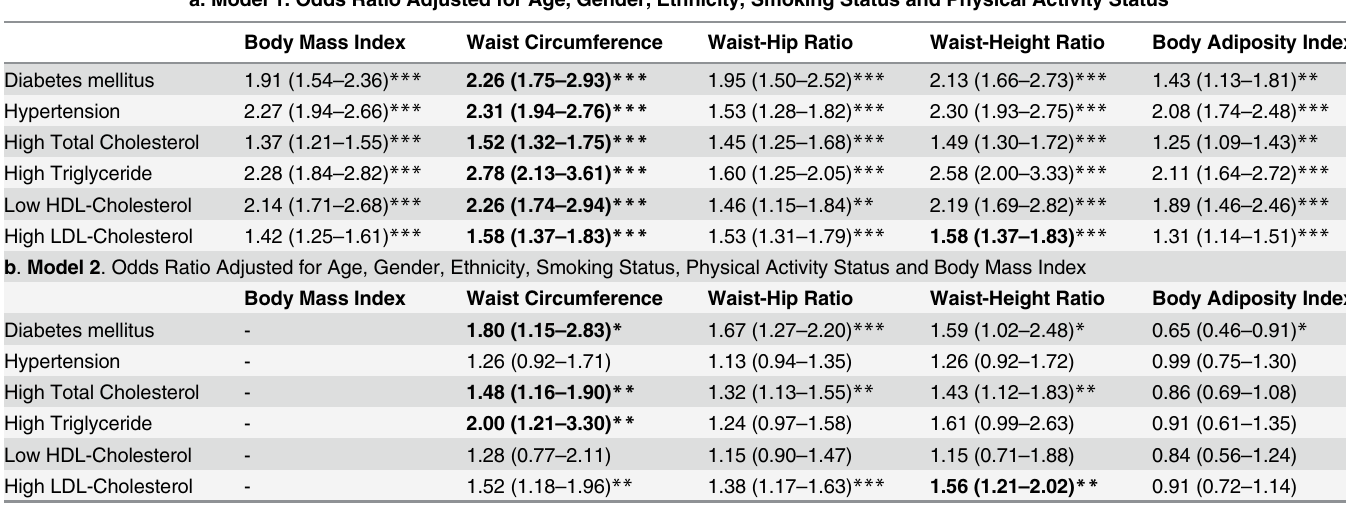
Table 5. Adjusted Odds Ratios of Cardiovascular Disease Risk Factors by Anthropometric Indices. a. Model 1. Odds Ratio Adjusted for Age, Gender, Ethnicity, Smoking Status and Physical Activity Status